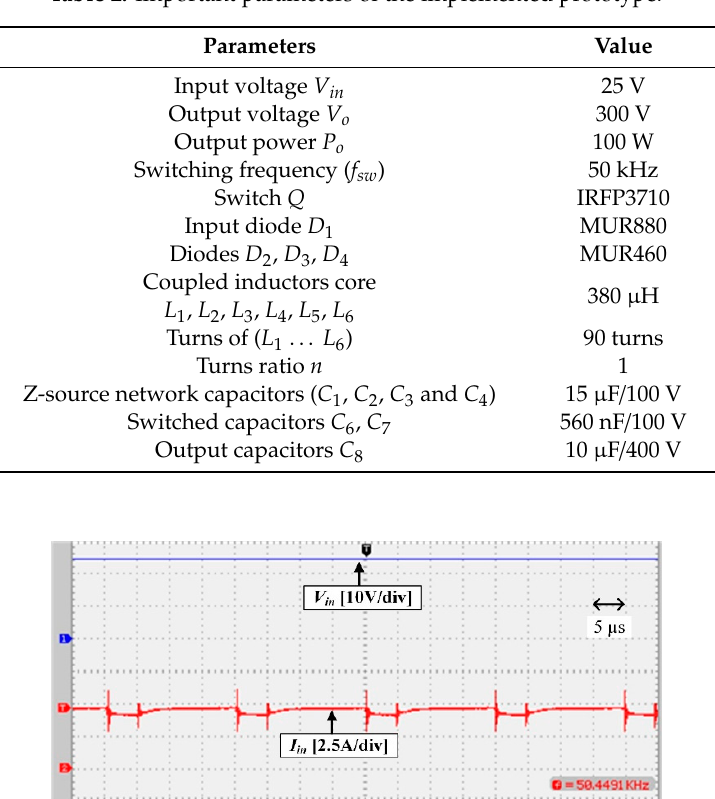
Figure 14. Voltage and current waveform of the diode D 4 . Figure 15. Output voltage and current waveform of the high step-up converter.